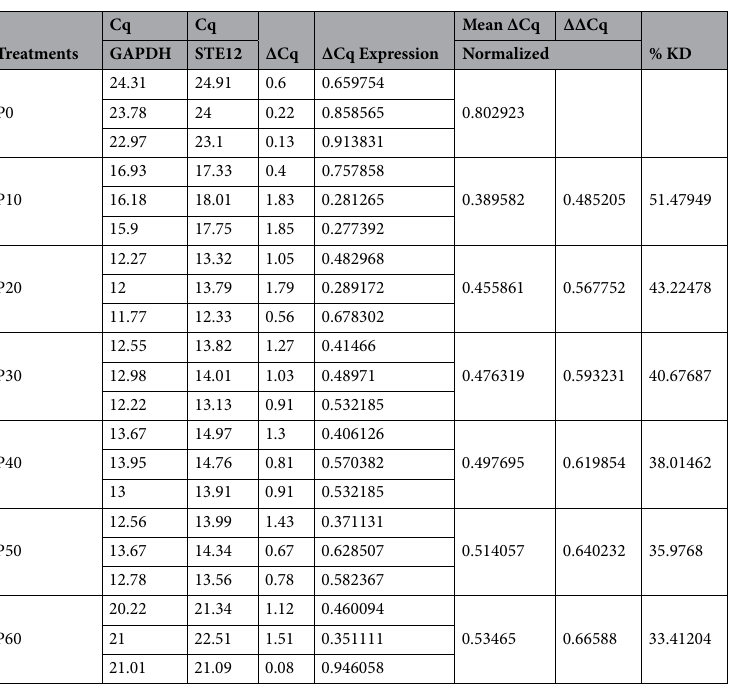
Table 2. % Knockdown values of real-time PCR of Phoma herbarum treatments against Penicillium janczewskii .